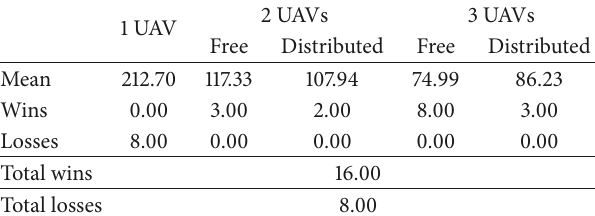
Figure 19: La Palma path planning results comparison for 1